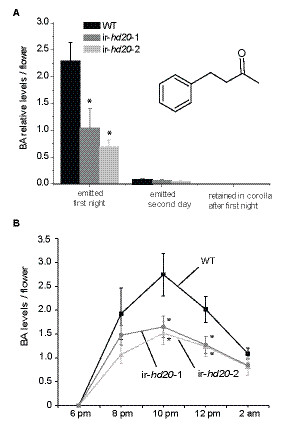
Analysis of BA produced in corollas ofir-hd20and WT plants. (A) The BA emitted from individual night flowers was trapped from 3 pm to 9 am and analyzed by GC-MS. The BA levels are expressed as the normalized peak areas to tetralin (internal standard; IS). Emitted BA was analyzed from both flowers that just opened their corollas (emitted first night) and from the same flowers but the day after (emitted second day). BA was also extracted from corolla tissue after the first night (retained in corollas after the first night). Asterisks denote significant differences; univariate ANOVA, F2,37 = 5.65 P < 0.01 followed by a LSD post-hoc test P < 0.01 for both lines versus WT; n > 10; bars denote ± SE. (B) Kinetic of BA emission from flowers at different times during corolla opening. Emitted BA was analyzed in real time with a zNOSETM. Asteriks denote significant differences; univariate ANOVA, 10 pm: F2,12 = 4.18 P < 0.05, 12 am: F2,12 = 4.20 P < 0.05 followed by a LSD post-hoc test P < 0.05 for both lines versus WT; n > 10; bars denote ± SE).